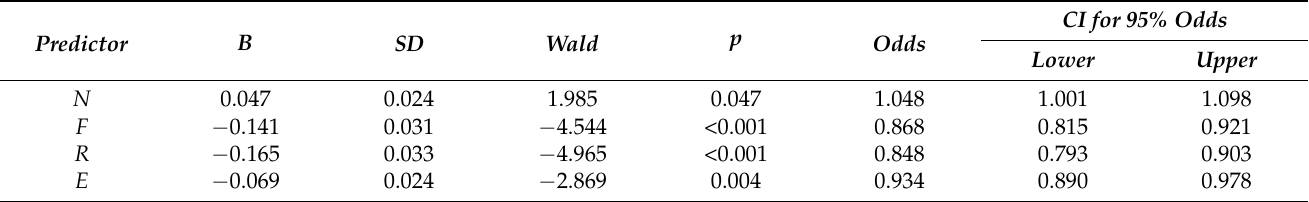
Table 5. Personal accomplishment (PA) ˆ L s ( N , F , R , E ) = ˆ B 0 + ˆ B N N + ˆ B F F + ˆ B R R + ˆ B E E ; s =